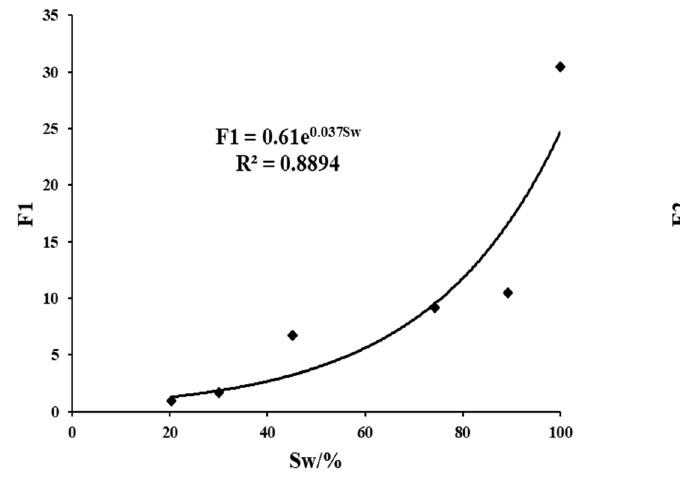
Figure 24. Calculation flow of parameters F1 and F2.